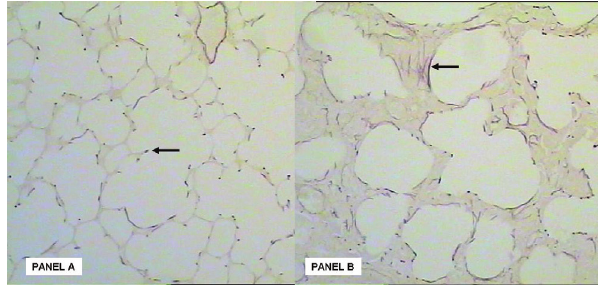
Figure 3 - Panel A: Weigert stained section (magnification X20). Elastin fiber deposition in lung parenchyma at the Air group. There is an organiza- tion of elastin fiber in the secondary alveolar septa (arrow). Panel B: After hyperoxic stimuli there is an evident disorganization and abnormal deposition of elastin fibers in the lung intersticium